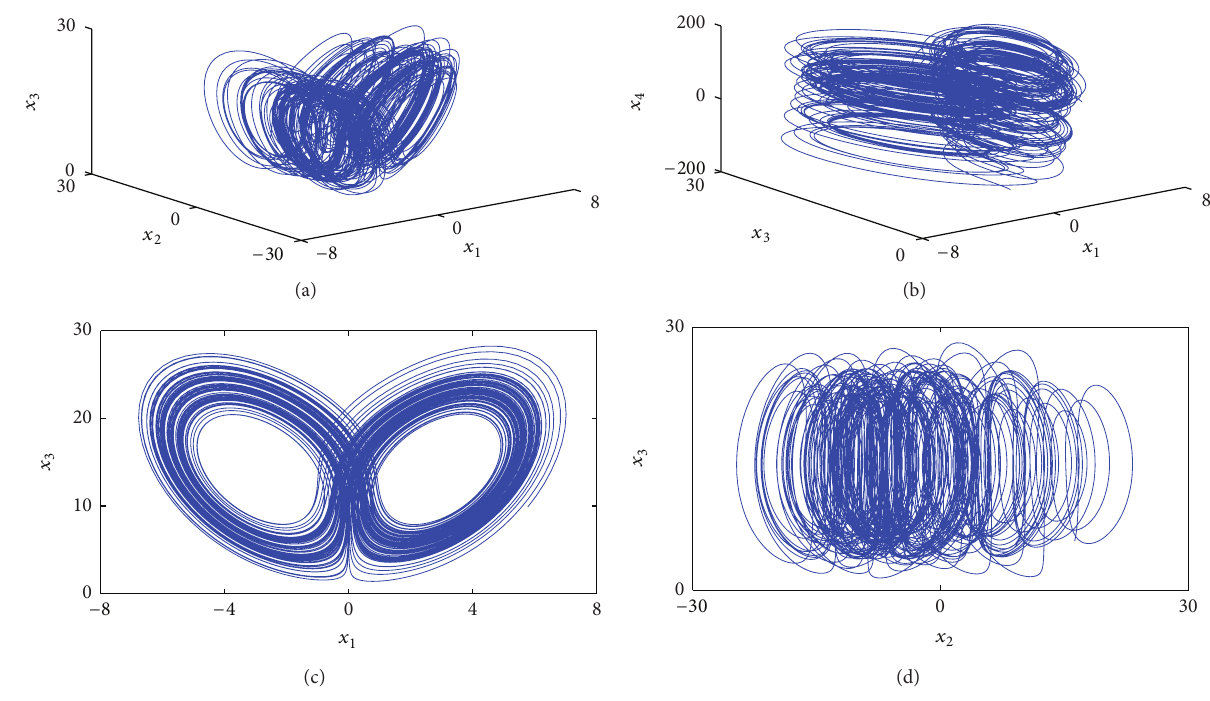
Figure 2: The chaotic attractor of 4D fractional-order system